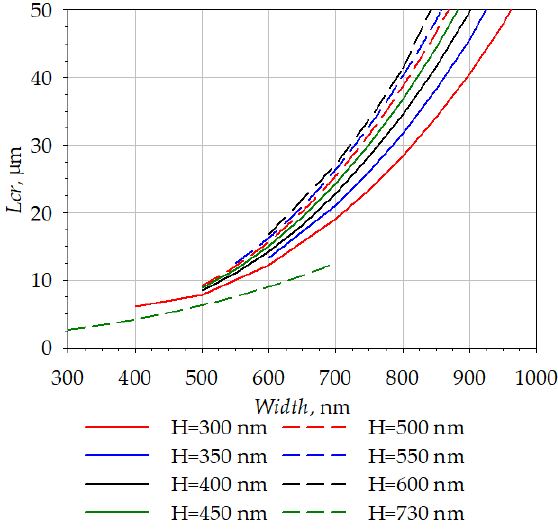
Figure 6. Dependence of the coupling length on the waveguide parameters.